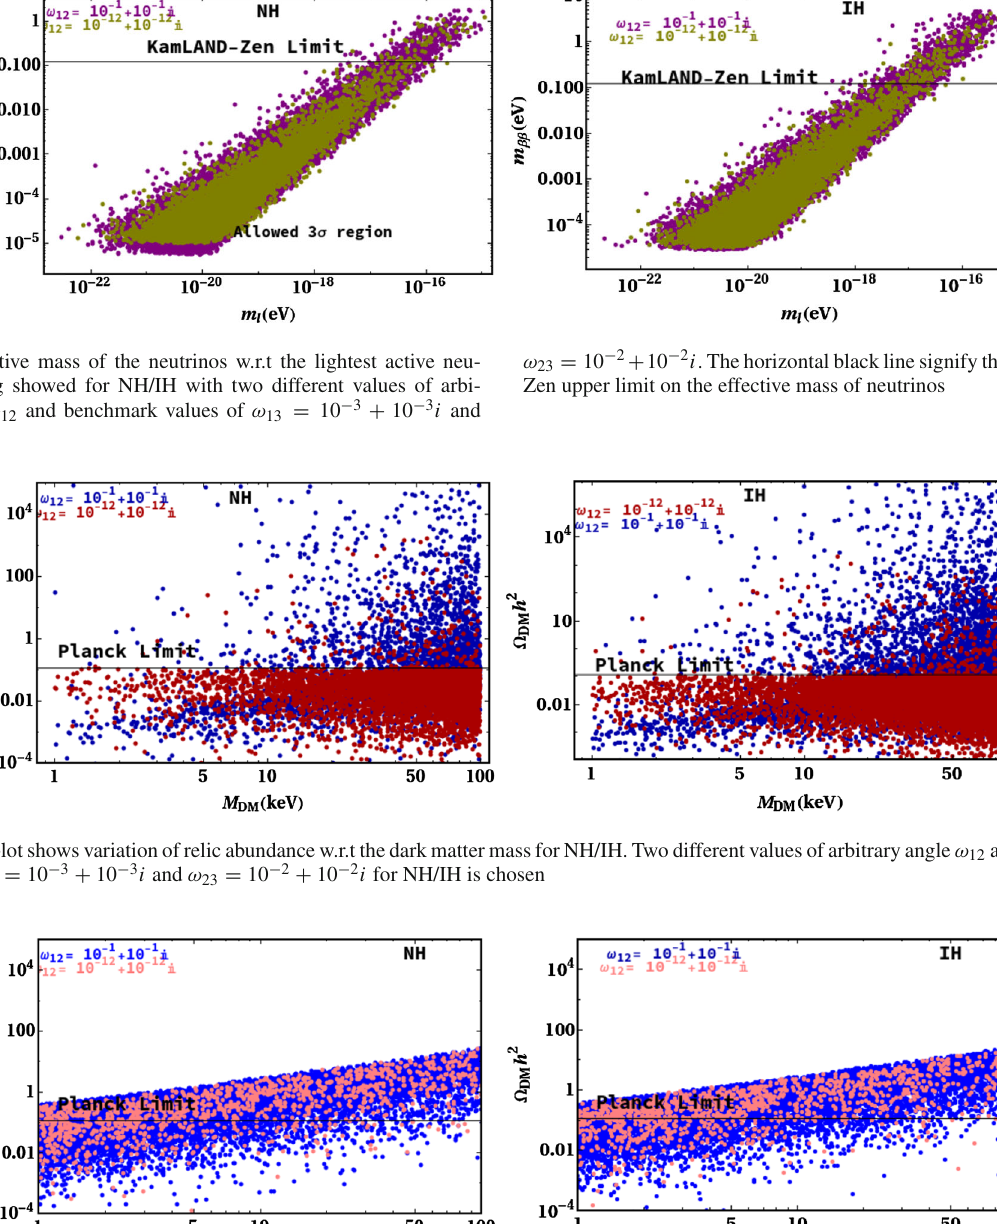
for NH/IH for two different values of arbitrary angle ω 12 and 1